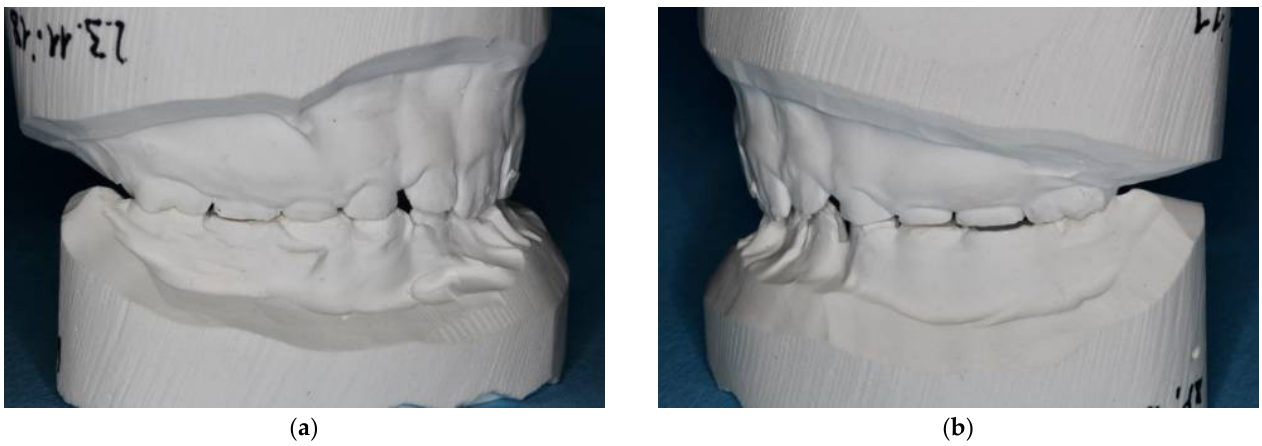
Figure 4. Plaster models of upper and lower jaws showing loss of tooth wear because of attrition and abrasion (physical tooth wear): ( a ) right side; ( b ) left